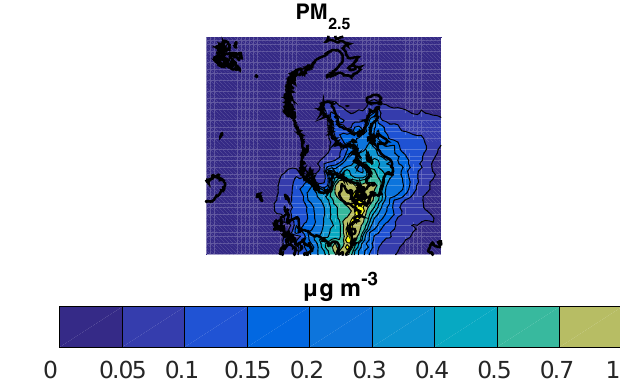
Figure 15. Concentration of PM 2 . 5 caused by shipping.